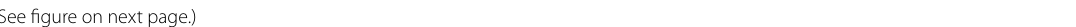
figure on next Fig. 4 Female patient 49 years old with HCC at segment VII underwent RFA. MRI study was done after 13 weeks after ablation and revealed low ADC value and diffusion restriction in a viable lesion. The lesion showed an intermediate signal at T1WI ( a ), an isointense signal at T2WI ( b ); at DCE series showed arterial phase hyperenhancement ( c ) and gradual washout at portal phase ( d ) and delayed phase ( e ), restricted diffusion seen at DWI at b value 500 ( f ) and 800 ( g ), with corresponding low signal at ADC series (H) ADC value